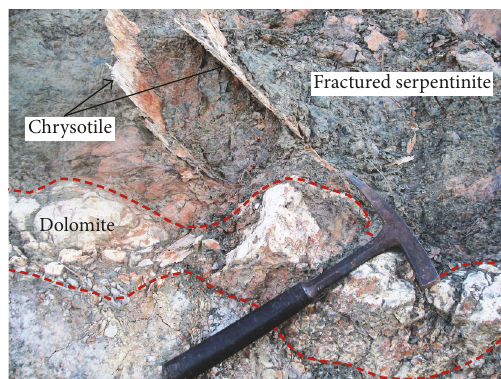
Figure 5: Field image of a large fracture system (crosscutting the highly fractured serpentinite rock in Kızılcada˘g ophiolitic m´elange) filled/sealed with chrysotile (i.e., fibrous asbestos) and secondary dolomite. Hammer for scale is 33 cm